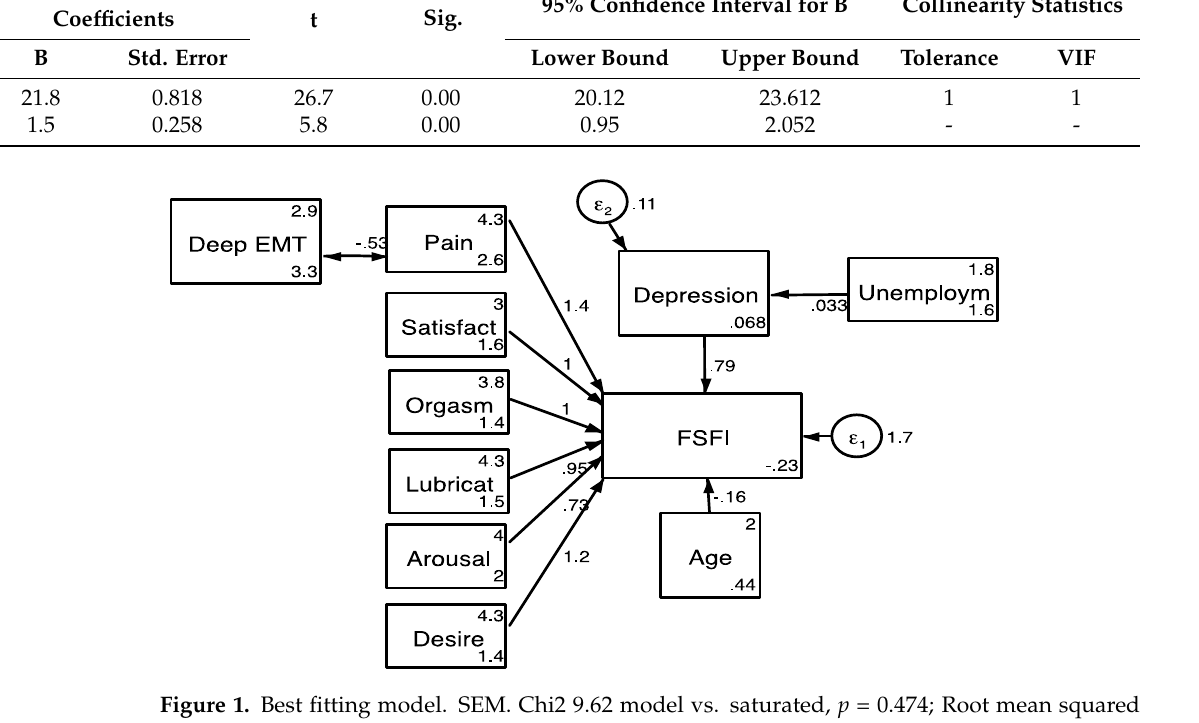
Figure 1. Best fitting model. SEM. Chi2 9.62 model vs. saturated, p = 0.474; Root mean squared error of approximation 0.00; Akaike’s information criterion, 5686.080; Bayesian information criterion, 5911.913; Comparative fit index, 1.000; Tucker–Lewis index, 1.002; Coefficient of determination